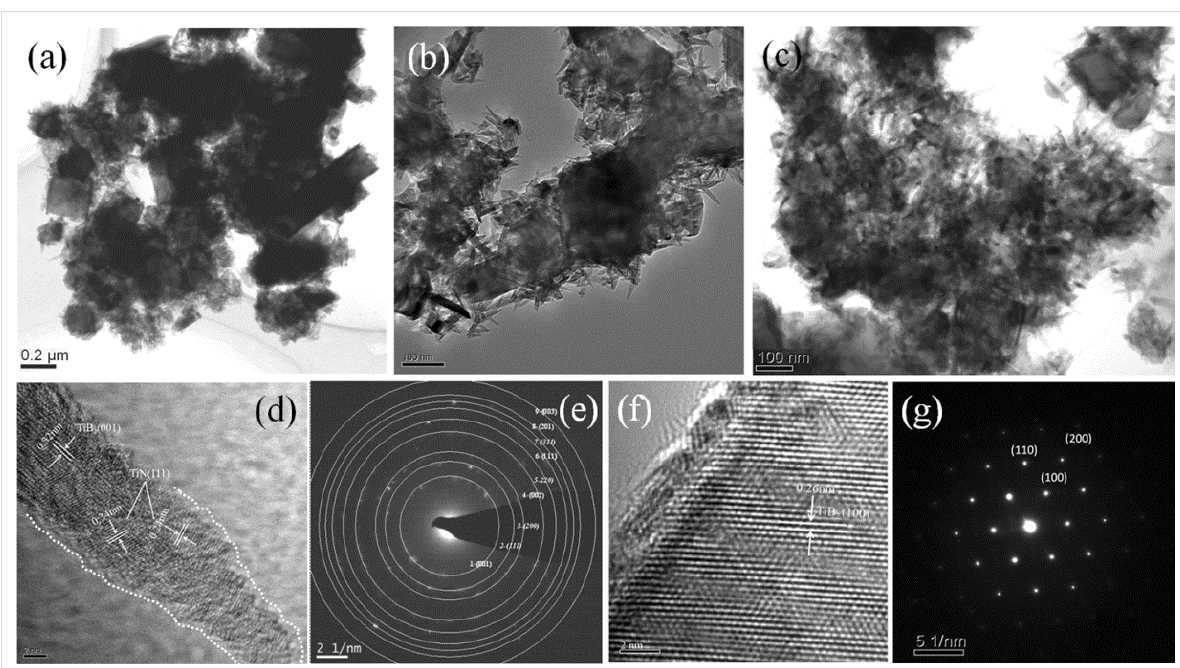
Figure 2: Typical TEM (a–c), and high-resolution TEM (d, f) images and selected-area electron diffraction (SAED) patterns (e, g) of the as-synthe- sized TiB 2 /(TiB 2 –TiN) samples. Scale bars: (a) 0.2 μ m, (b) 100 nm, (c) 100 nm, (d) 2 nm and (f) 2 nm.